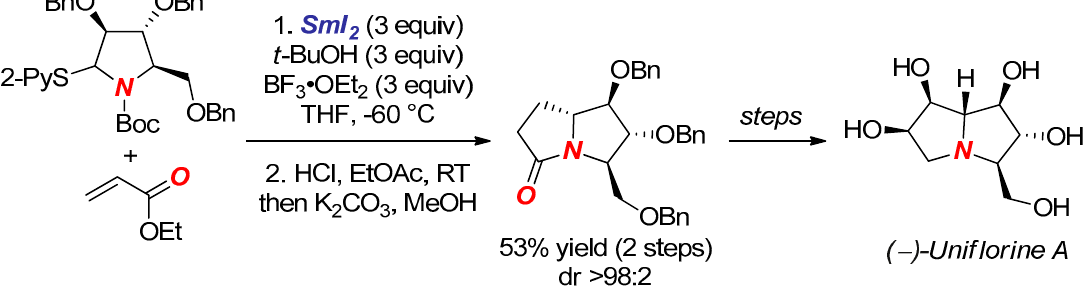
Scheme 13. Synthesis of ( − )-Uniflorine by Intermolecular Cross-Coupling of N , S -Acetals.